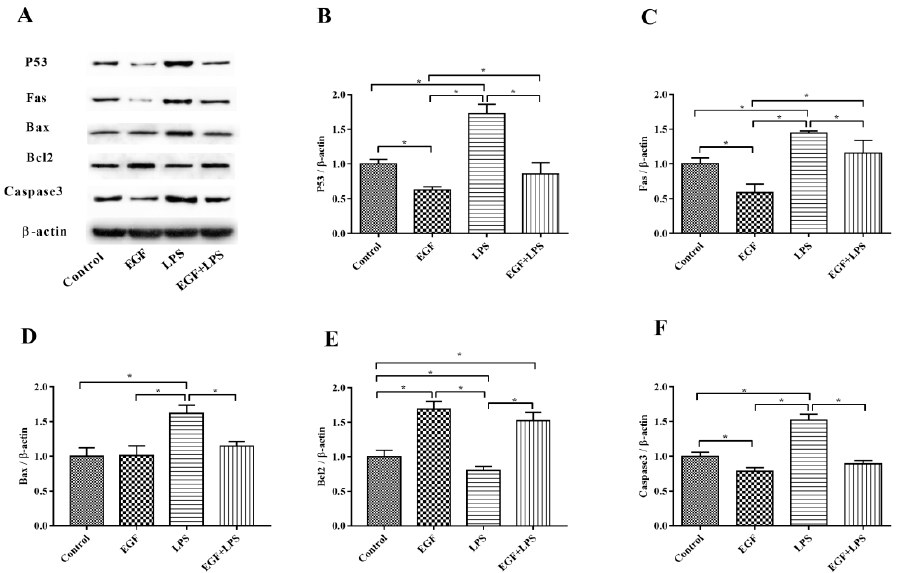
Figure 7. Effects of EGF on pro-apoptotic and anti-apoptotic proteins expression induced by LPS. ( A ) Representative charts of Western blot results; ( B ) P53; ( C ) Fas; ( D ) Bax; ( E ) Bcl2; ( F ) Caspase3. Densitometric values were normalized to β -actin and expressed as a relative level to control values. Data are presented as mean ± SD, n = 3, * p < 0.05.